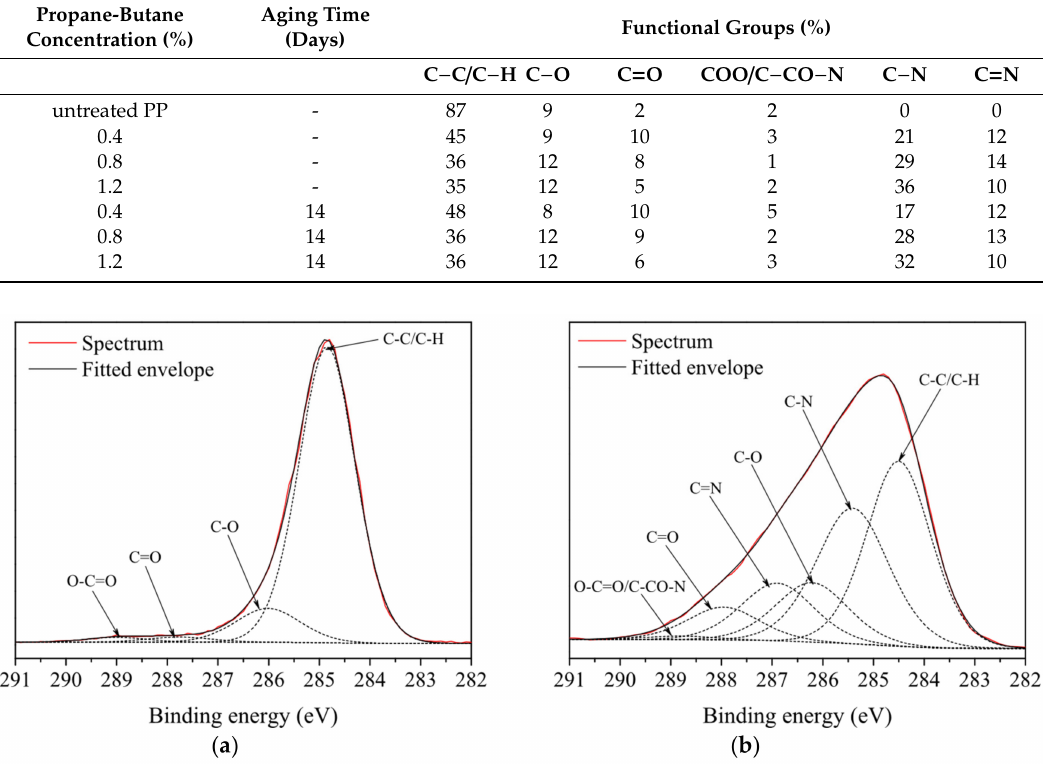
Table 2. Percentage (%) of peak areas (functional groups) in C1s peaks of untreated and plasma-modified surfaces for three di ff erent compositions of processing gas, i.e., 0.4, 0.8, and 1.2% of P-B in nitrogen. XPS spectra were measured immediately after plasma treatment and after 14 days of aging in ambient air. A treatment time of 15 seconds was kept in all cases.